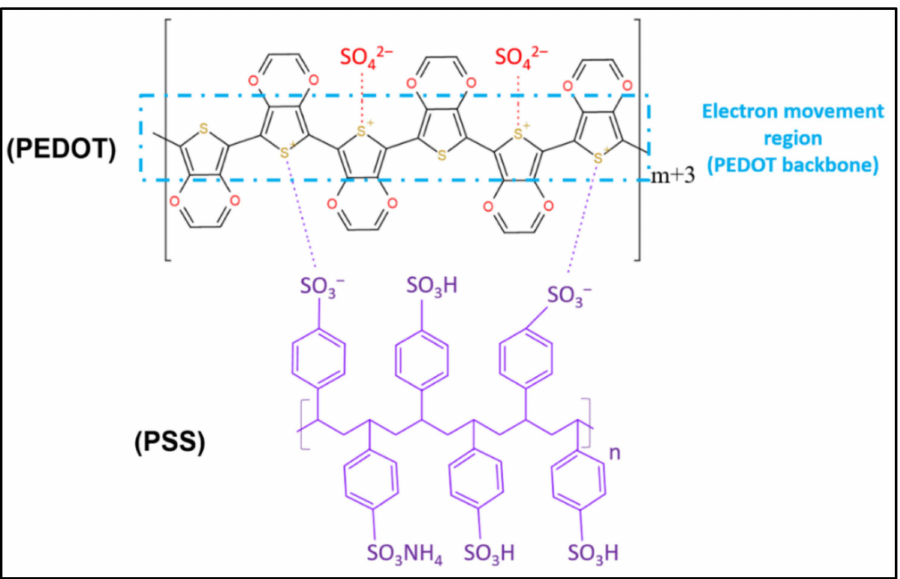
Figure 13. The chemical structure of PEDOT: PSS with the presence of sulfonate ions from an oxidant